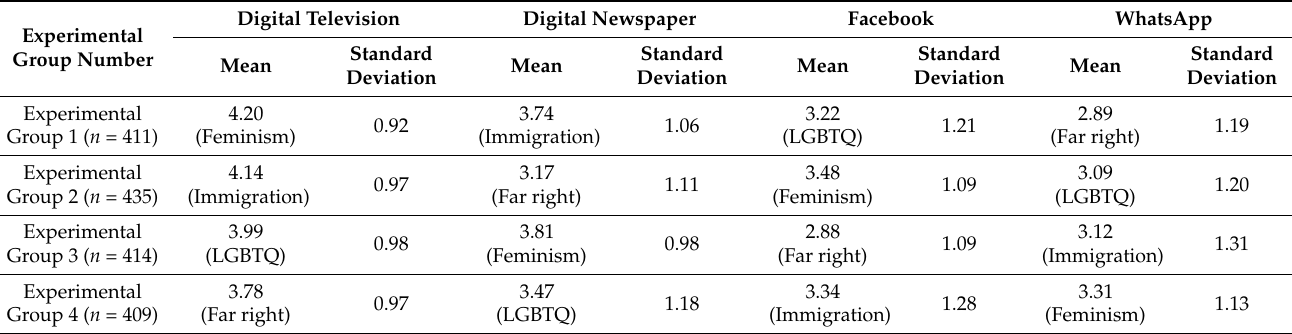
Table 2. Mean credibility assigned to the online news by